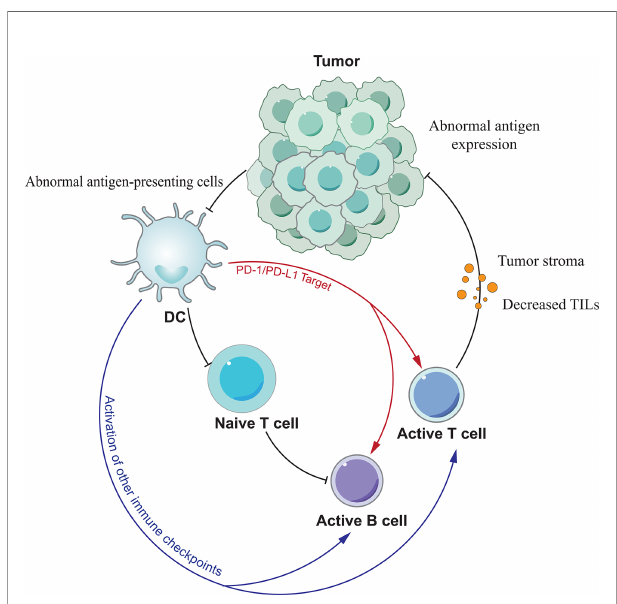
FIGURE 2 | The mechanism of PD-1/PD-L1 antibody resistance. Various factors lead to resistance mainly by affecting the function of T